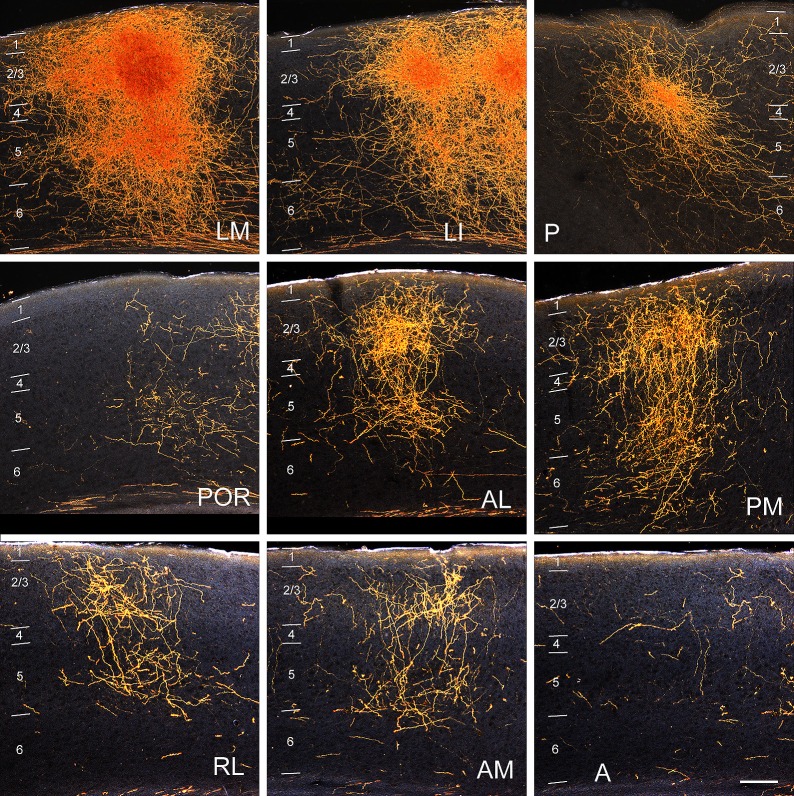
Darkfield images of the termination patterns of BDA-labelled axonal projections from V1 to LM, LI, P, POR, AL, PM, RL, AM and A.Images are taken from the boxed regions shown in 1A. All projections are FF, which target L2-4 more strongly than L1. Scale bar, 0.5 mm.